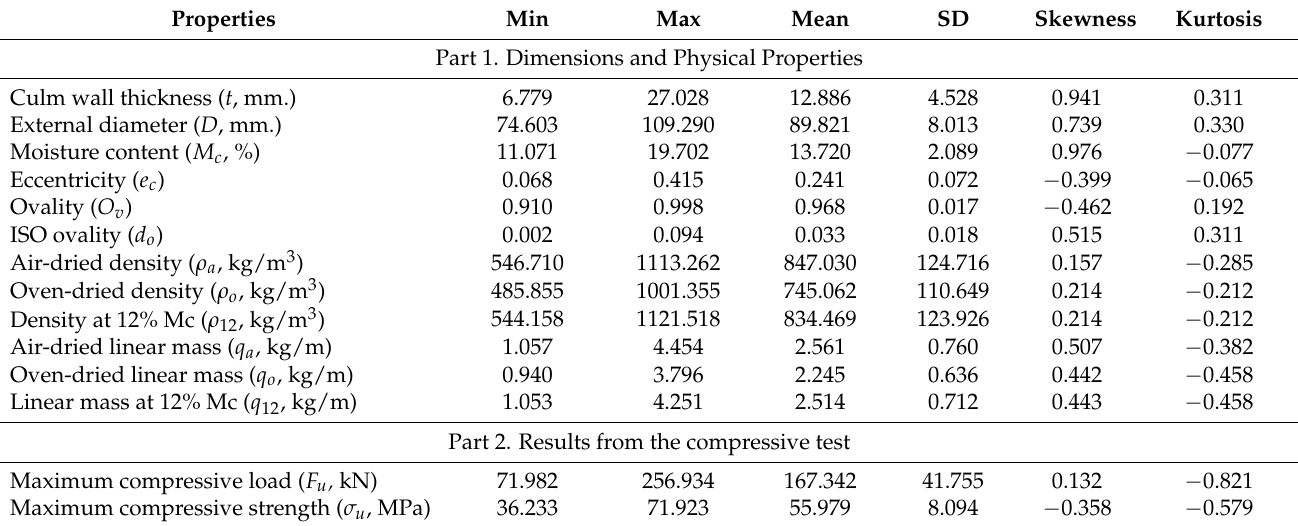
Table 2. Descriptive statistics of dimensions and physical properties in Part 1 and results from the compressive test in Part 2.